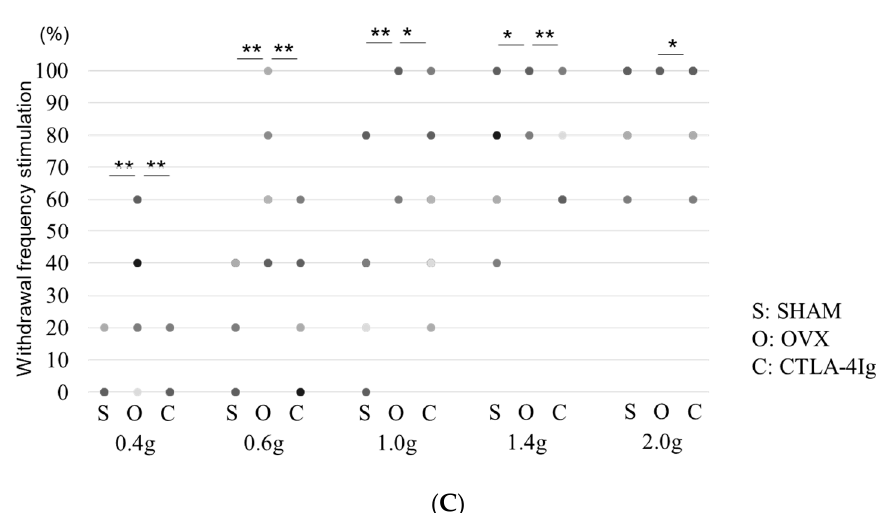
Figure 1. Measurement of pain-related behavior with von Frey filaments. ( A ) Paw withdrawal threshold; ( B ) 50% paw withdrawal threshold by the up–down method; ( C ) withdrawal frequency stimulation. Data are shown as scatter plots (* p < 0.05, ** p < 0.01, **** p < 0.001; n = 12 in each group). SHAM, sham-operated mice, OVX, ovariectomy-treated mice, CTLA-4Ig, cytotoxic T lymphocyte-associated antigen-4 immunoglobulin G.